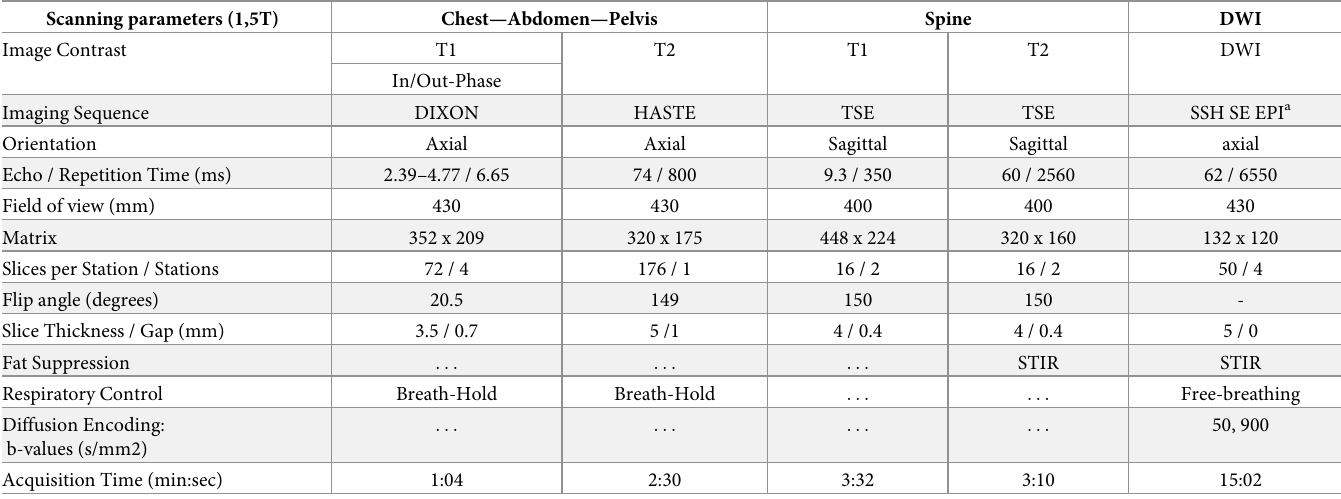
Table 1. Scanning parameters for